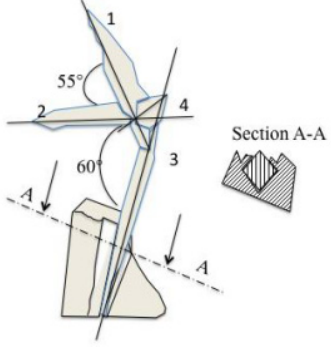
Figure 14. Sketch representing the needles network in Figure